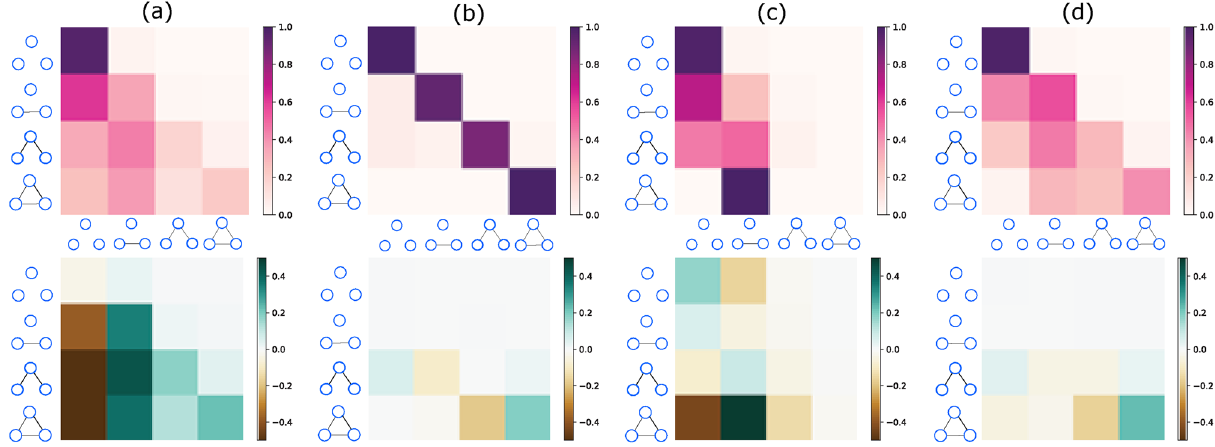
T evaluated for real world networks. The average values (cid:31) T (cid:30) (4) are Figure 3. The Triplet transition matrix T (cid:30) of (8), are shown shown on the top row while the average of differences from the simple pairwise model, (cid:31) (cid:31) (cid:31) (cid:31) T matrix shown on the bottom row. Each of the four-by-four heat map grids is organised in the same way as the (cid:31) in Fig. 2. That is, the rows indicate the initial triplet state ( m 0 to m 3 from top to bottom as indicated) and the (cid:31) T (cid:30) on the top row columns indicate the final triplet state ( m 0 to m 3 from left to right as indicated). The values of (cid:31) T ( s ) (cid:30) on the bottom row, values run from dark brown (-0.5) through run from 0 (white) to 1.0 (dark red). For (cid:31) � (cid:31) white (0.0) to dark blue ( + 0.5 ). Each column of heat maps is for a different data set; from left to right we have: (cid:31) (a) Turkish Shareholder networks ( (cid:31) t = 2yr ), p = 3.49 × 10 − 2 , q = 0.638 , (b) Wikipedia Mathematicians networks ( (cid:31) t = 1yr ), p = 5.71 × 10 − 4 p = 3.19 × 10 − 4 , q = 0.068 , (c) College Message networks ( (cid:31) t = 1mo ), p = 0.067 , q = 0.510 , and (d) Email networks ( (cid:31) t = 1mo ), p = 9.43 × 10 − 3 , q = 0.432 . The actual time difference between snapshots G ( s ) and G ( s + 1 ) is (cid:31) t